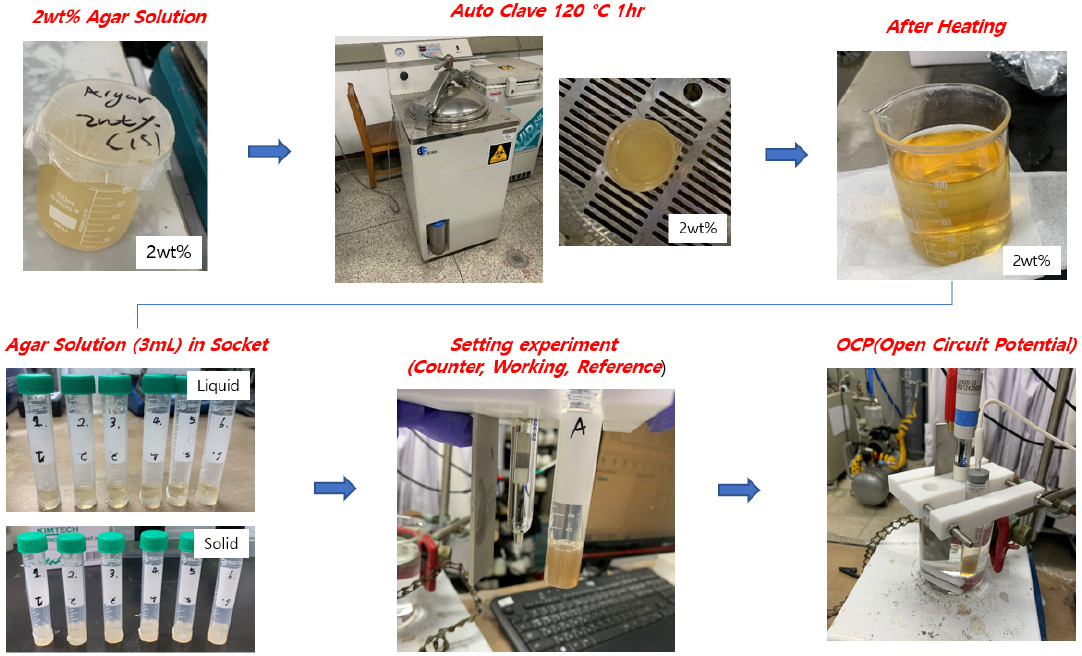
Figure 2. Fabrication process and photos for the agar sensor platform and OCP measurement.